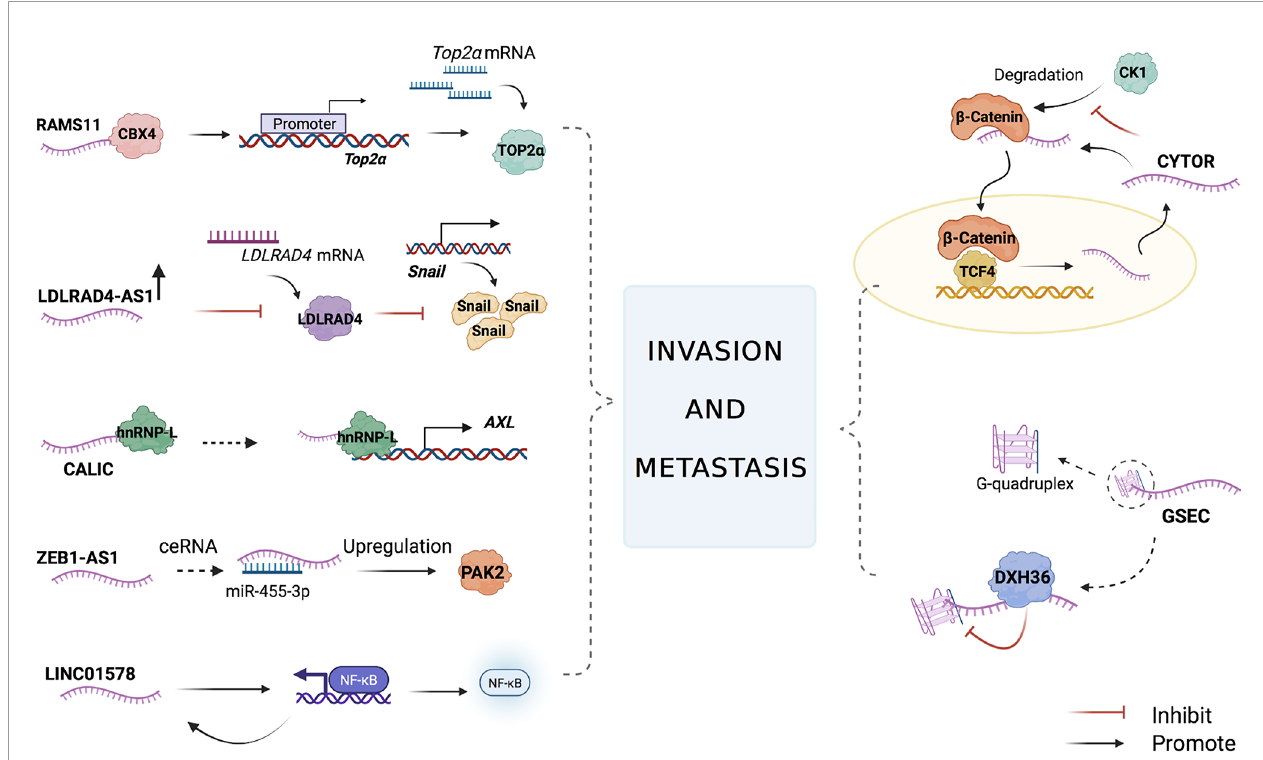
FIGURE 3 | The main mechanisms of lncRNAs in CRC cell invasion and metastasis. LncRNAs participate in the CRC cell invasion and metastasis by combining with proteins to regulate the target downstream, affecting miRNA translation, acting as miRNA sponges, regulating the expression of transcriptional factors, and activating nuclear factor kappa-B